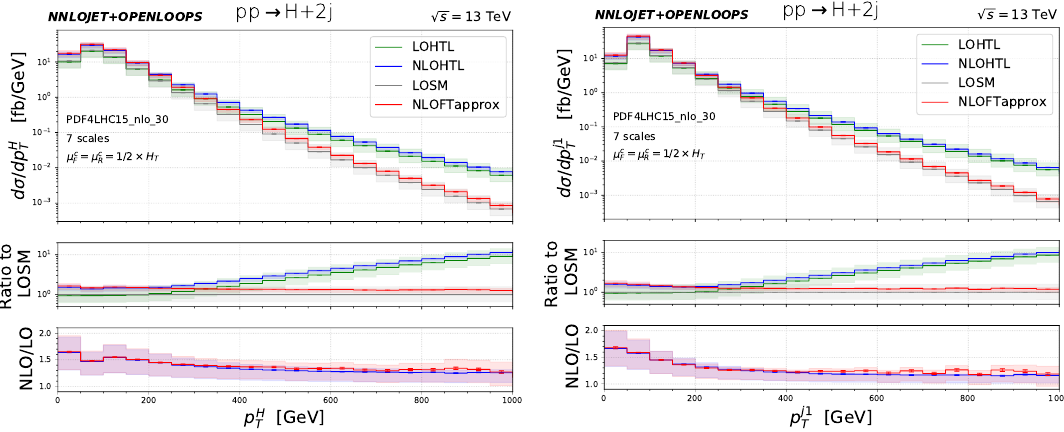
Figure 4 . Transverse momentum distribution of the Higgs (left) and the hardest jet (right) in H + 2 jets production. Colour coding and labelling as in figure